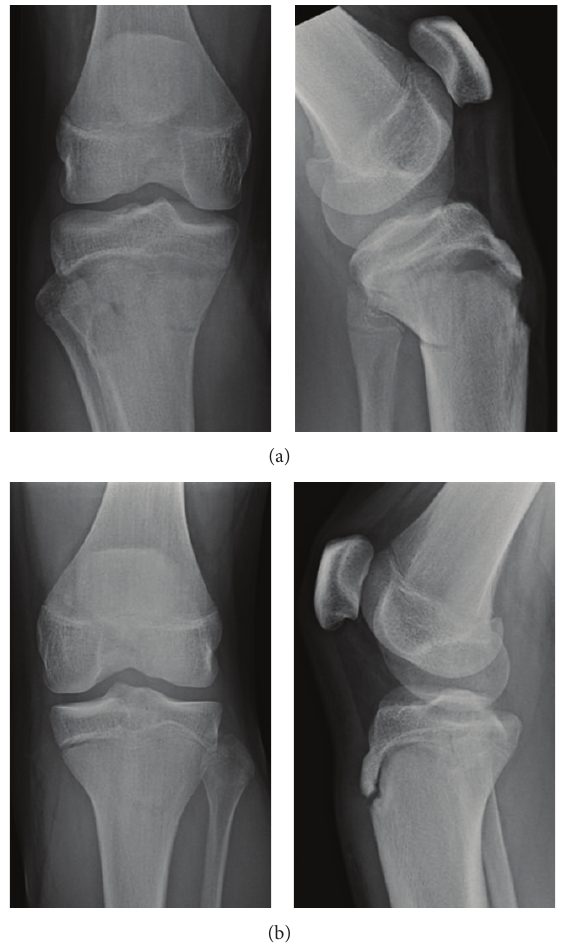
Figure 1: Plain radiographies of the right (a) and left knee (b) after trauma revealed transitional fractures of the proximal tibia, on the right side dorsally displaced, on the left side